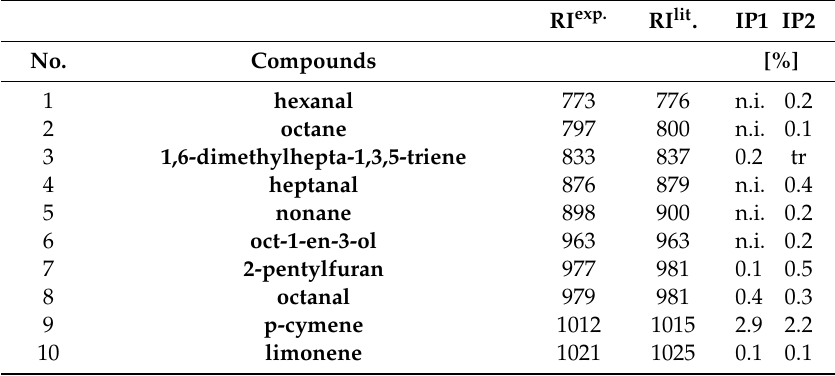
Table 2. Identified components of two samples of Impatiens parviflora .